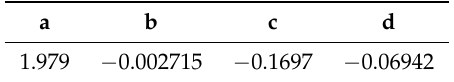
Table 2. Fitted parameters of the A5 battery.